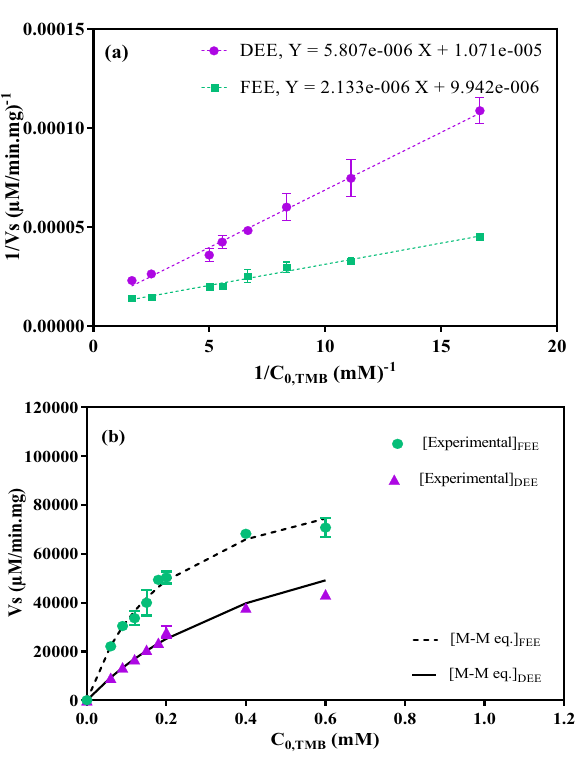
Figure 6. ( a ) Lineweaver–Burke Equation parameters “Eq. (4)” ( b ) The initial reaction rate obtained from the M–M equation and the experimental data at different substrate concentrations using the dried extracted enzyme (DEE) and freshly extracted enzyme (FEE).